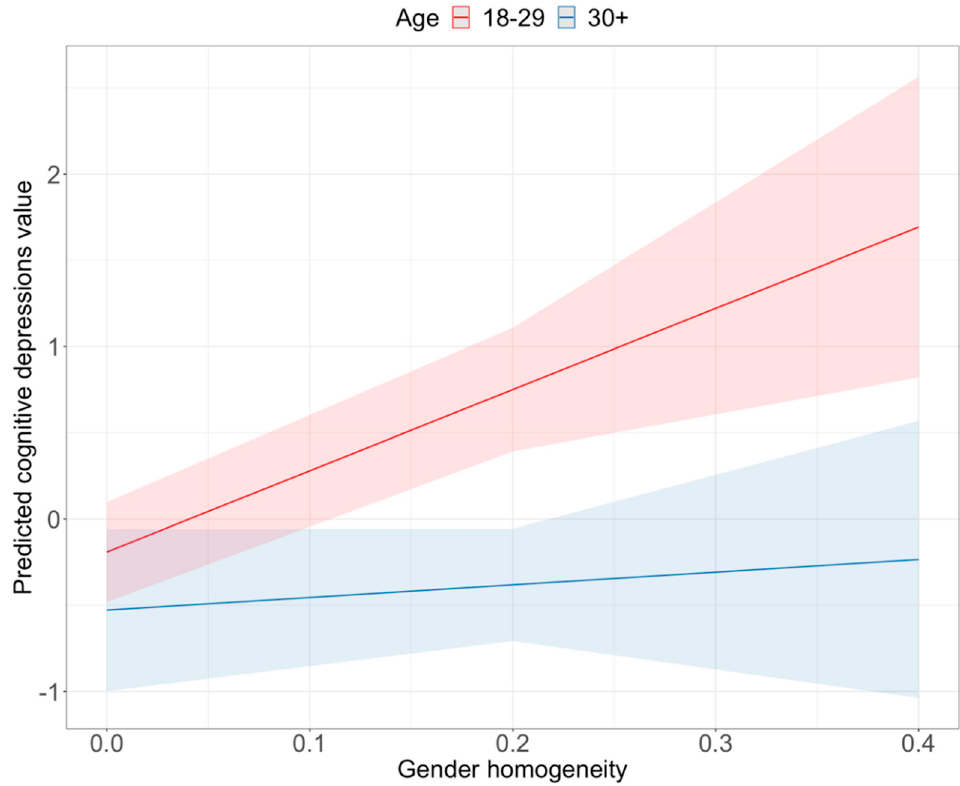
10 of 19 Table 3. Linear Regression model. Dependent variable: cognitive depression. Variables